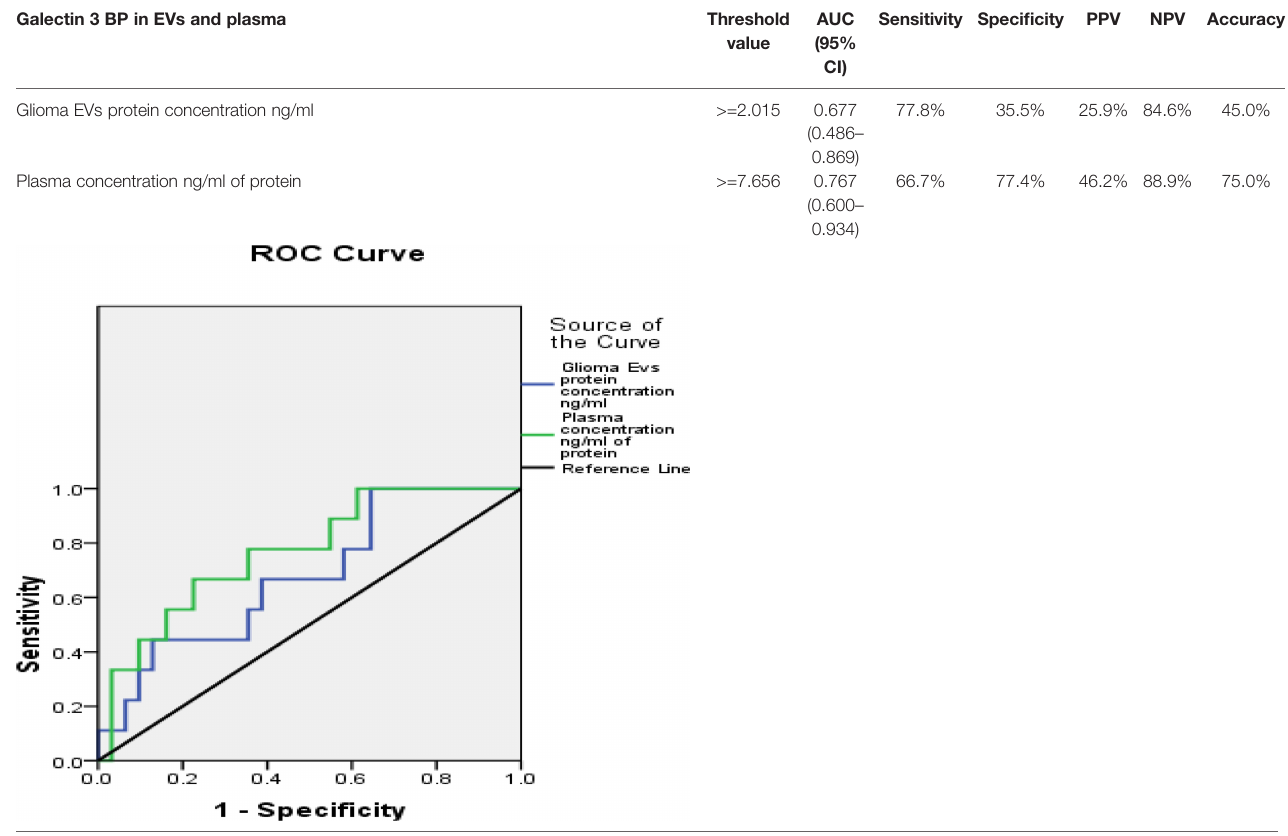
TABLE 2 | Correlation of plasma-derived EV concentration and plasma protein concentration with galectin-3 BP. Galectin 3 BP in EVs and